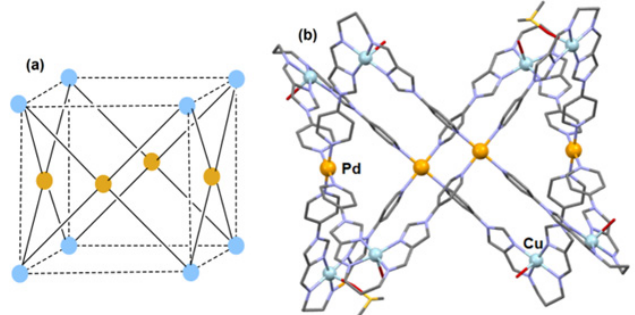
Figure 1. Structural details of the cubic cation in [Pd 4 (CuL) 8 (DMSO) 2 (H 2 O) 6 ](NO 3 ) 24 ( 2 ), where [CuL] 2+ is the metalloligand 1 . ( a ) Schematic representation of the metal ion sites in the partially face- centred cube. ( b ) Crystal structure of the cubic cation showing the square pyramidal coordination of each copper(II) centre and the square planar geometry of each palladium(II) centre which is bound to four pendent 4-pyridyl groups. Hydrogen atoms, lattice solvent molecules, and nitrate counterions are not shown [101].